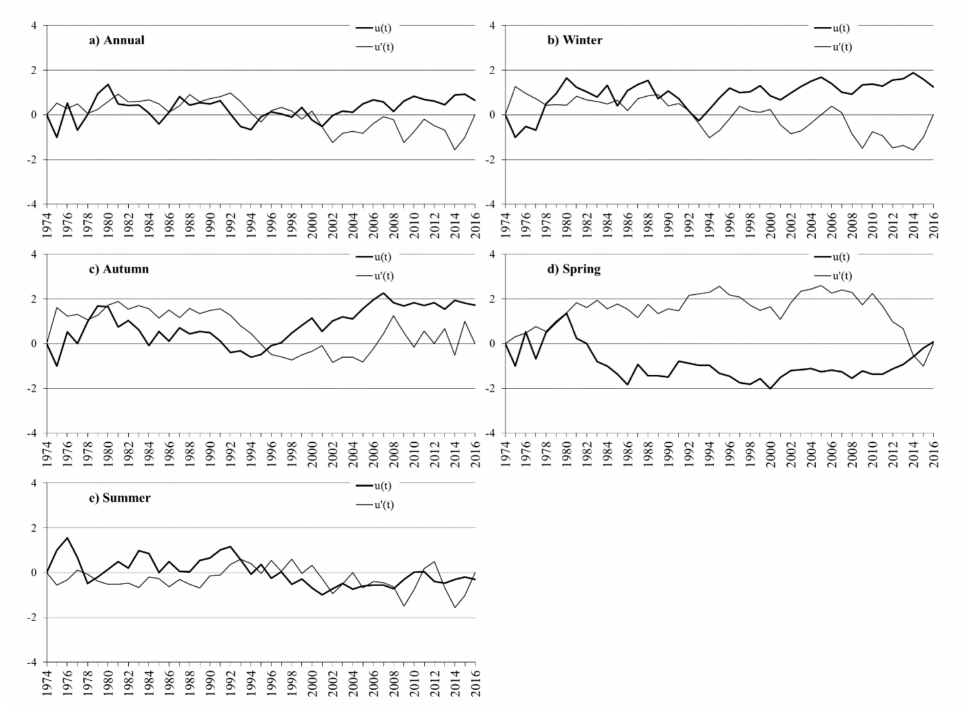
Figure 7. Graphical representation of the series u ( t ) and the retrograde series u ’( t ) of the sequential version of the Mann–Kendall test for ( a ) annual, ( b ) winter, ( c ) autumn, ( d ) spring, and ( e ) summer P/PET in the University Forest of